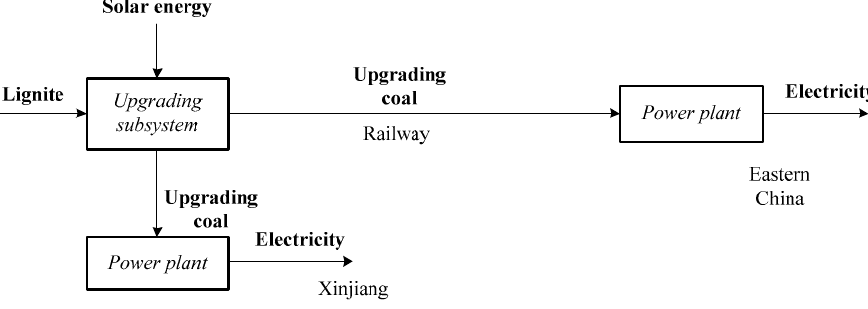
Figure 3. Solar–hybrid upgrading, power generation, and coal transport system.